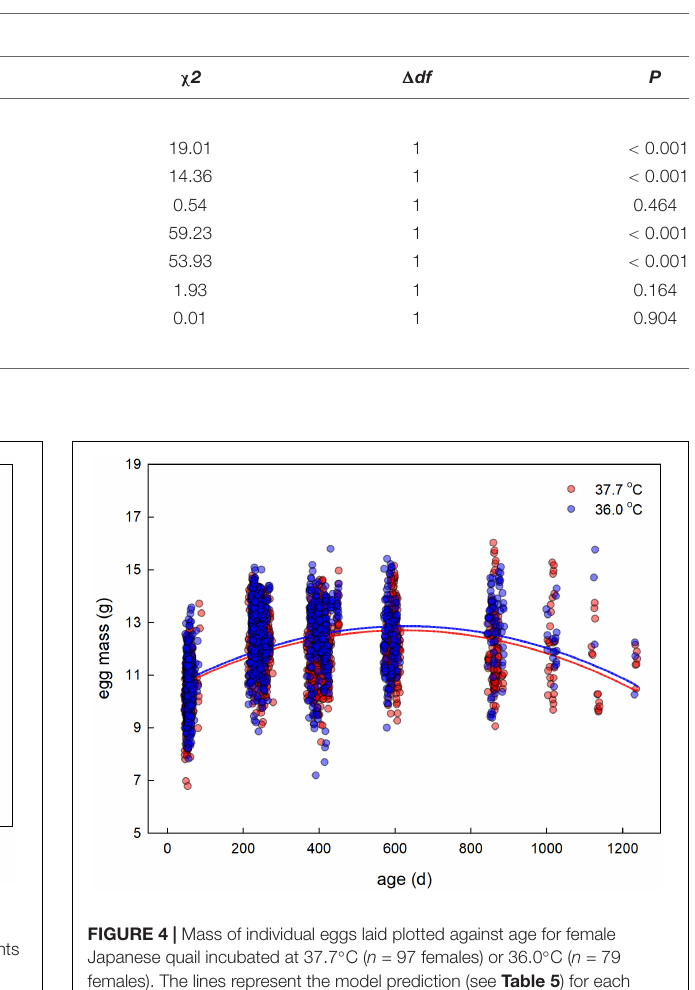
TABLE 3 | Summary of a linear mixed model testing for effects of incubation treatment on age-specific adult body mass in Japanese quail females.